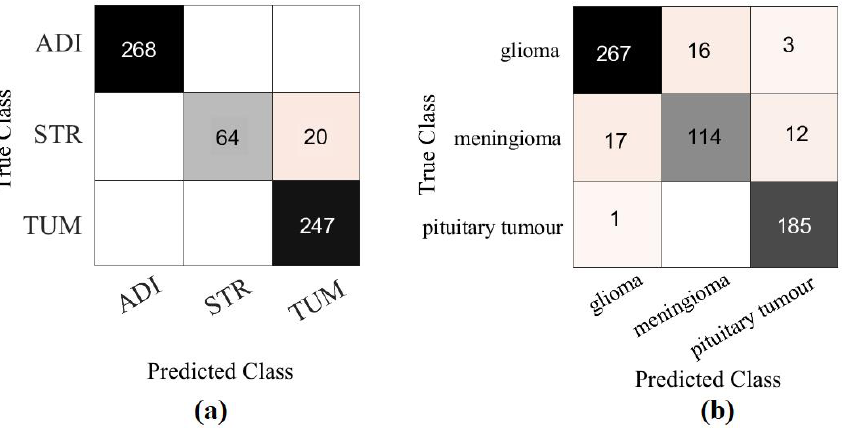
Figure 12. The confusion matrix results obtained in the test sets by using the AP-based class decom- position of XDecompo instead of the decomposition component of 4S-DT model: ( a ) CRC dataset, ( b ) Brain tumour